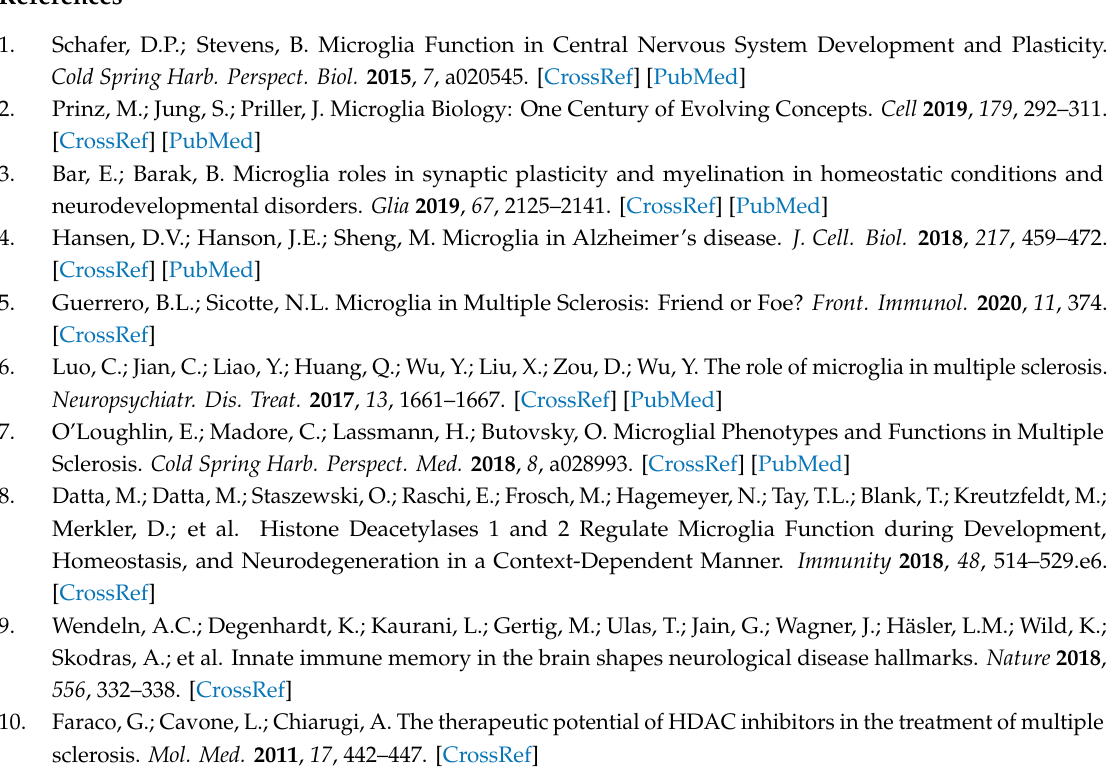
Figure S1: Timeline of experiments, Tables S1 to S8: Detailed results of statistical analysis for data shown in Figures 1 and